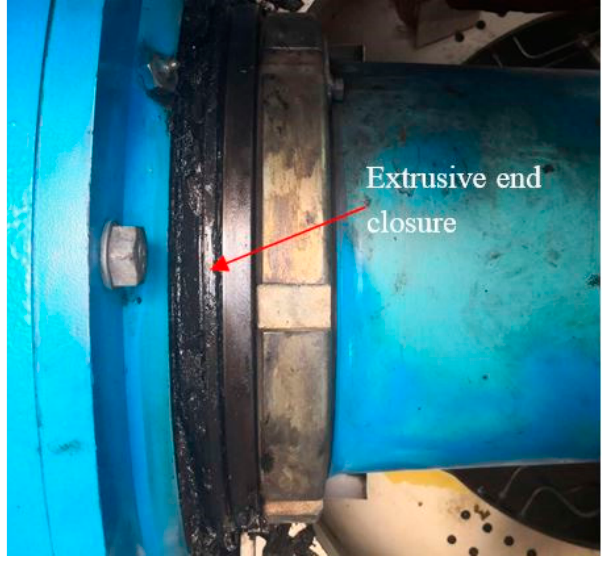
Figure 11d where the rotational frequency f i of the intermediate shaft dominates the whole envelope spectrum. The fault characteristic frequency f i is in accordance with the Figure 9. Extrusive end closure of the faulty main bearing. faulty pinion on the intermediate shaft.